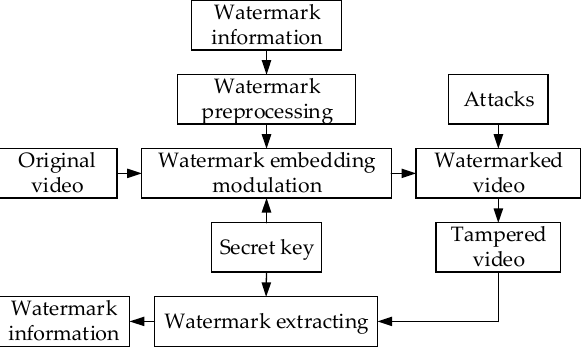
Figure 3. A framework of a general robust video watermarking algorithm.